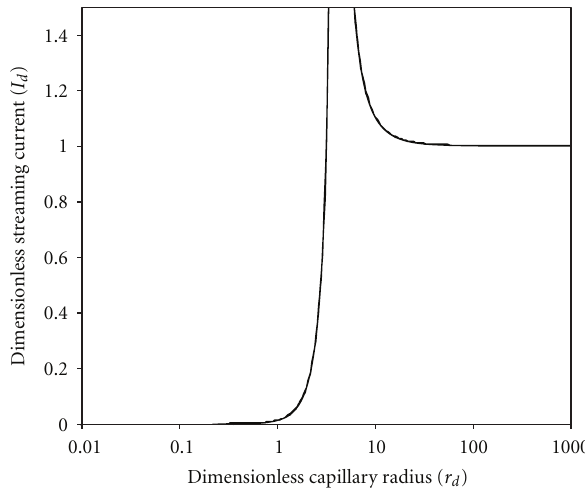
Figure 5: Dimensionless streaming current ( I d ) as a function of dimensionless capillary radius ( r d ) for a surface charge of Q s = 1mC · m − 2 . Curves corresponding to concentration values of 0.001 M, 0.01M, 0.1 M, 0.5M, 1M, and 2M are shown but cannot be